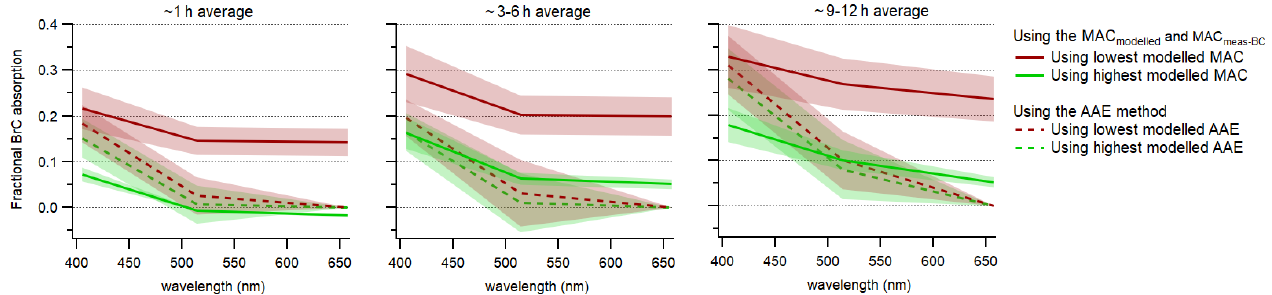
Figure 8. The simulated fractional contribution of BrC to total aerosol absorption, including different wavelengths and sampled smoke with different ages. The solid red and green lines represent the mean results calculated from the MAC modelled and measured MAC meas-BC using the lowest and highest modelled MAC, respectively. The dashed red and green lines represent the mean results calculated from the AAE methods using the lowest and highest modelled AAEs. The shading represents the